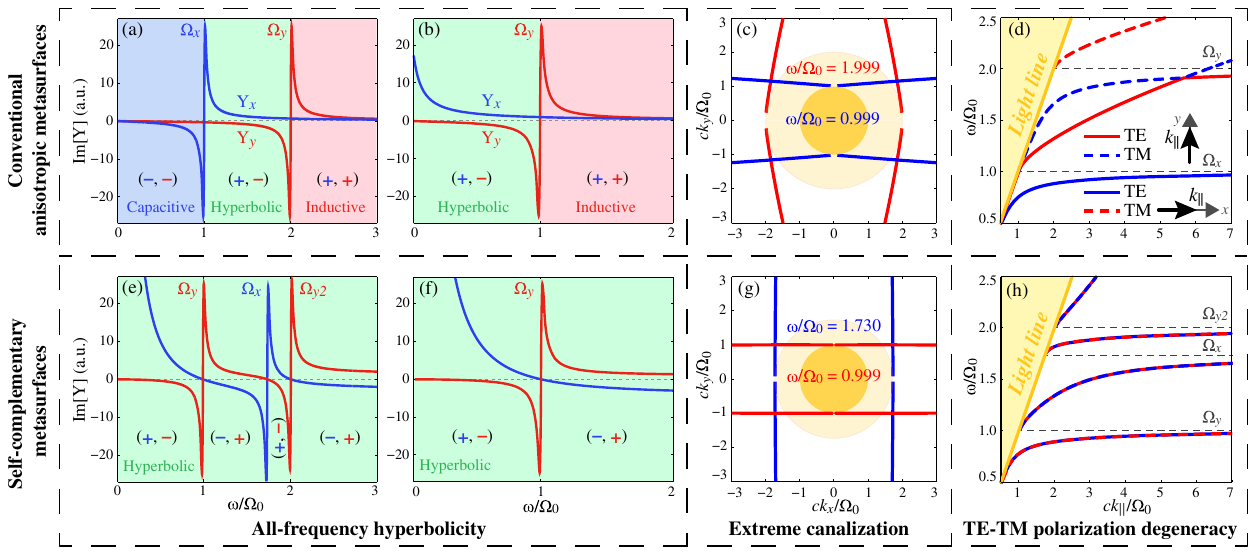
FIG. 1. Three topical issues related to the near-field properties of surface waves on the conventional anisotropic two-dimensional systems (a) – (d) and self-complementary metasurfaces (e) – (h). (a,b,e,f) I. Hyperbolic regime of a metasurface corresponding to Þ Im ð Y Þ < 0 . The dependence of the imaginary parts of the admittance tensor components Y Im ð Y (blue lines) and Y (red lines) on the x y x y frequency in the dimensionless units normalized per the frequency of the first resonance Ω 0 . The signs “ þ ” and “ − ” correspond to Þ , respectively. The green area corresponds to the hyperbolic regime of a metasurface. The ; Y the positive and negative values of ð Y x y resonant frequencies of the conventional anisotropic 2D systems ( Ω , Ω ) and the self-complementary metasurfaces ( Ω , Ω ) are x y y y 2 ¼ 2 , (e) Ω ¼ 2 ] and (b,f) far from each other [namely, (b) Ω ≪ 1 , (f) Ω ≪ 1 ]. = Ω = Ω = Ω = Ω spectrally (a,e) close [namely, (a) Ω y x y 2 y x y y 2 y (c,g) II. Extreme (divergenceless) canalization corresponding to absolutely flat isofrequency contours. (c,g) Isofrequency contours in the vicinity of the resonances (c) Ω (blue line) and Ω (red line) for conventional anisotropic metasurface, and (g) Ω (blue line) and Ω (red x y y x line) for the self-complementary metasurface. The circles correspond to the light cone at the same frequencies. (d,h) III. All-frequency TE-TM polarization degeneracy. We show the dependence of frequency on the in-plane wave-vector component k k for TE- and TM- polarized surface waves propagating along the x and y directions for (d) conventional anisotropic and (h) self-complementary metasurfaces. The yellow region corresponds to the light cone. The parameters of the surface admittance tensor components for hyperbolic and self-complementary metasurfaces can be found in the Supplemental Material